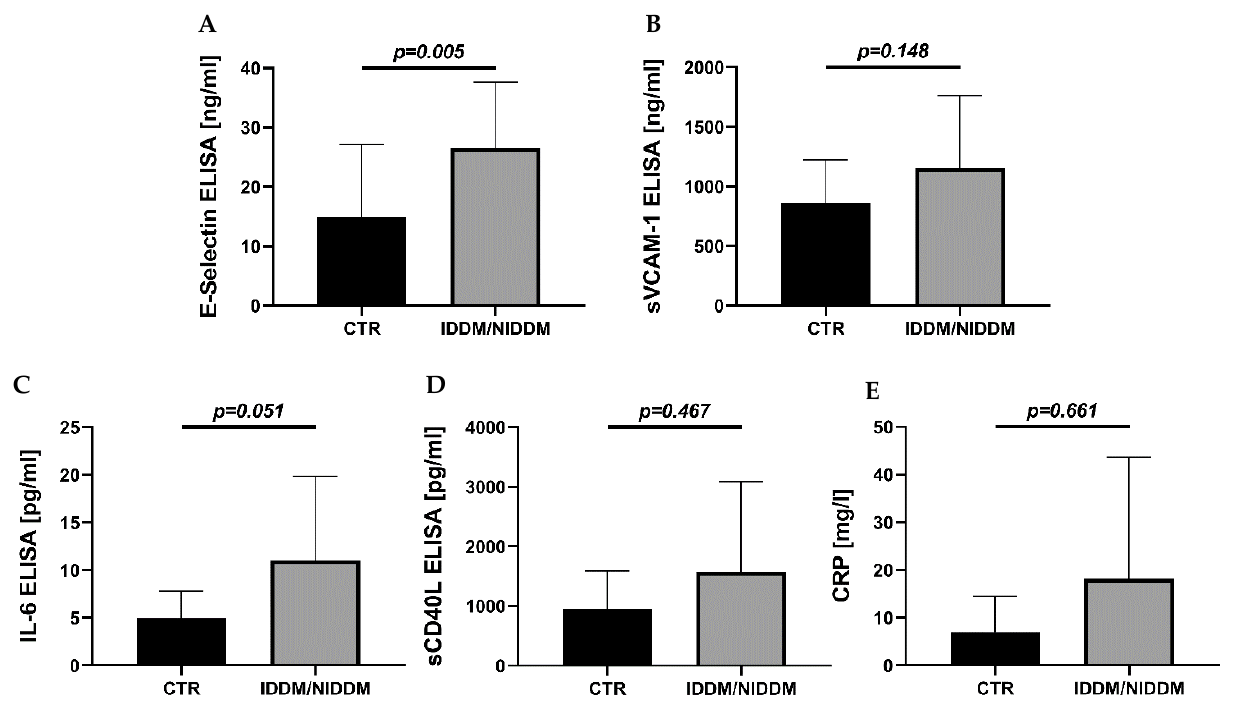
Figure 3. Serum markers of inflammation. ( A ) Significant raise of E-selectin in the diabetic (IDDM/NIDDM) versus the control (CTR) group. ( B ) Enhanced concentration of VCAM-1 in the IDDM/NIDDM versus CTR group (n.s). ( C ) Increased concentration of interleukin-6 (IL-6) in the IDM/NIDDM versus CTR group (n.s.). ( D ) Increase in concentration of CD40L and ( E ) C-reactive protein (CRP) in the DM versus CTR group (n.s.). Data are mean ± SD of n = 15 (CTR) and 11 (IDDM/NIDDM) patients ( A – D ) or n = 11–12 ( E ). Mann–Whitney test in ( A , D , E ) and unpaired t test in ( B , C ). CTR, control; IDDM, insulin-dependent diabetes mellitus type 2; NIDDM, non-insulin-dependent diabetes mellitus type 2.